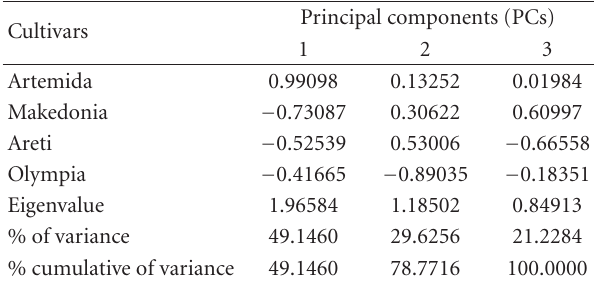
Table 4: Correlation of each cultivar with the three principal com-